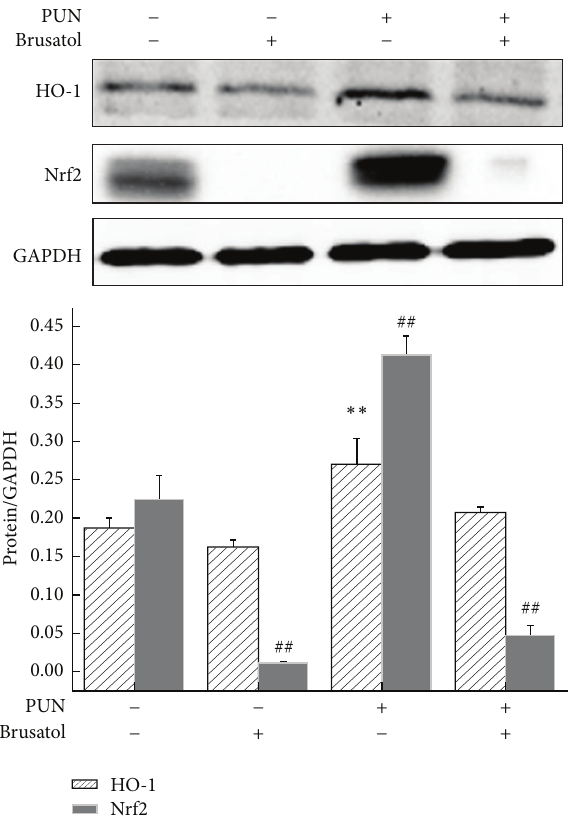
Figure 2: Inhibition of Nrf2 suppresses PUN induced HO-1 protein expression in RAW264.7 cells. Cells were treated for 8h with 100 𝜇 M PUN in the presence or absence of 20 nM brusatol at 37 ∘ C in a humidified incubator with 5% CO 2 . The HO-1 and Nrf2 protein expression were analyzed by Western blotting. Data represent the mean ± SEM of three independent experiments and differences between mean values were assessed by one-way ANOVA. ∗∗ 𝑃 < 0.01 and ## 𝑃 < 0.01 indicate significant differences compared with the control